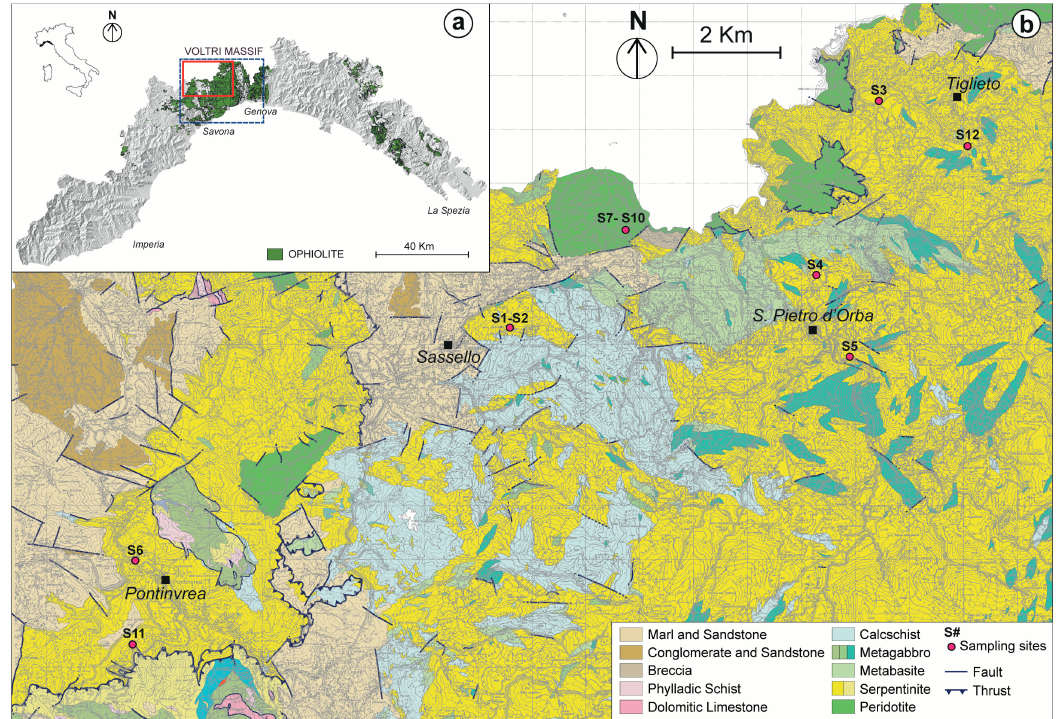
Figure 1. ( a ) Location of the study area (red box) within the Voltri Massif (Blue dashed box). Map supplied as Open Data by the Liguria Regional Government [49]. ( b ) Geological map of the study area with the sampling sites location (red dots); modified after [50]. Geographical information on sites S1-S12 is reported in Table